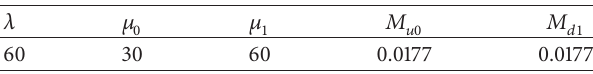
Table 3: Random mobility example.